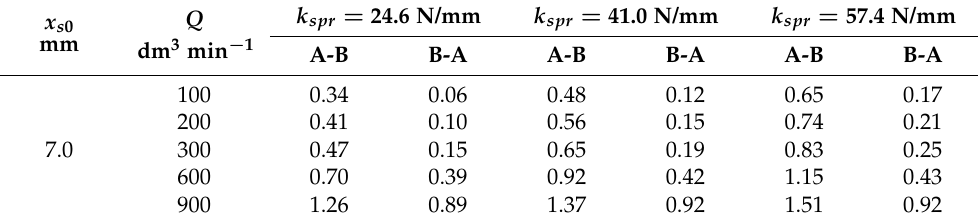
Table 5. Check valve pressure drop (MPa) against flow rate Q and spring stiffness k spr .